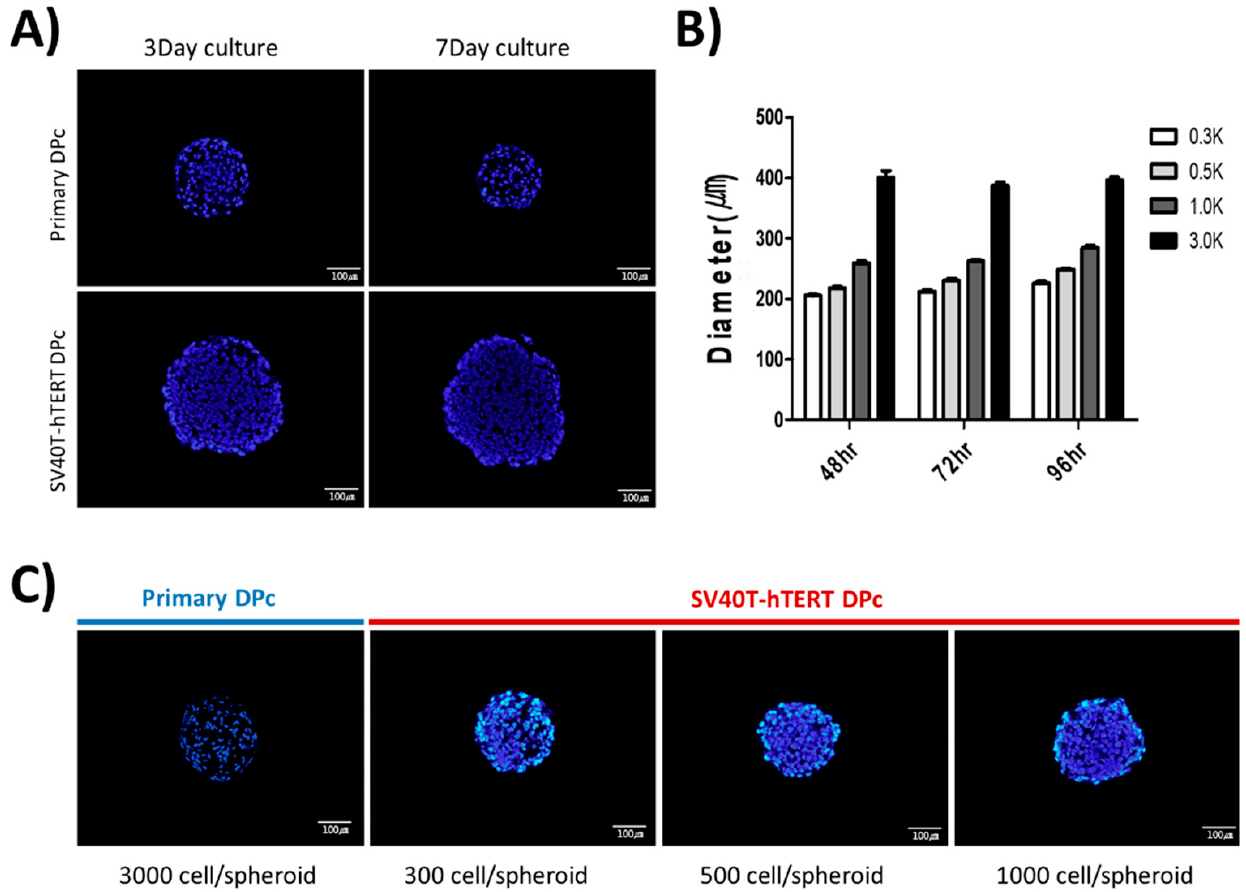
Figure 2. Spheroid aggregation pattern of human dermal papilla-derived cells. ( A ) Spheroid sections of primary DPc and SV40T-hTERT DPc using the same cell number (3000) for aggregation at two time points. ( B ) SV40T-hTERT DPc spheroid diameter changes over time for the initial cell population of each spheroid. ( C ) Comparison of SV40T-hTERT DPc spheroids in under 1000-cell populations with a primary DPc spheroid aggregated within 3000 cells after 72 h incubation. The cell